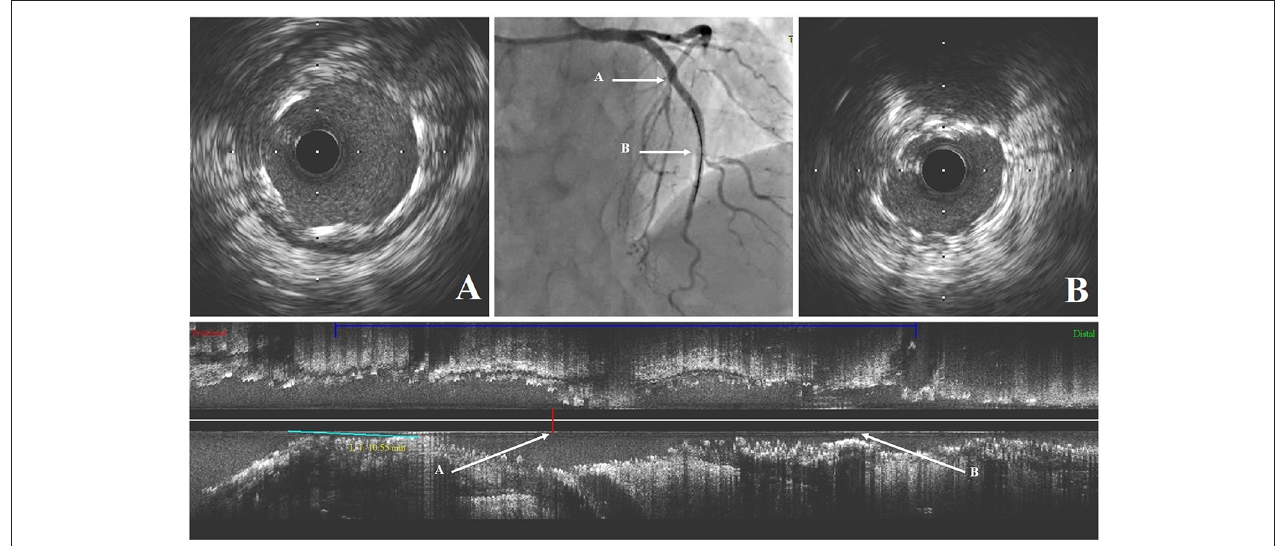
FIGURE 8 | The intravascular ultrasound findings after stenting. (A) Cross-sectional intravascular image of LAD stent just proximal to the septal branch branching point; (B) Cross-sectional intravascular image of LAD stent just proximal to the 2nd diagonal branch branching point. LAD, left anterior descending coronary